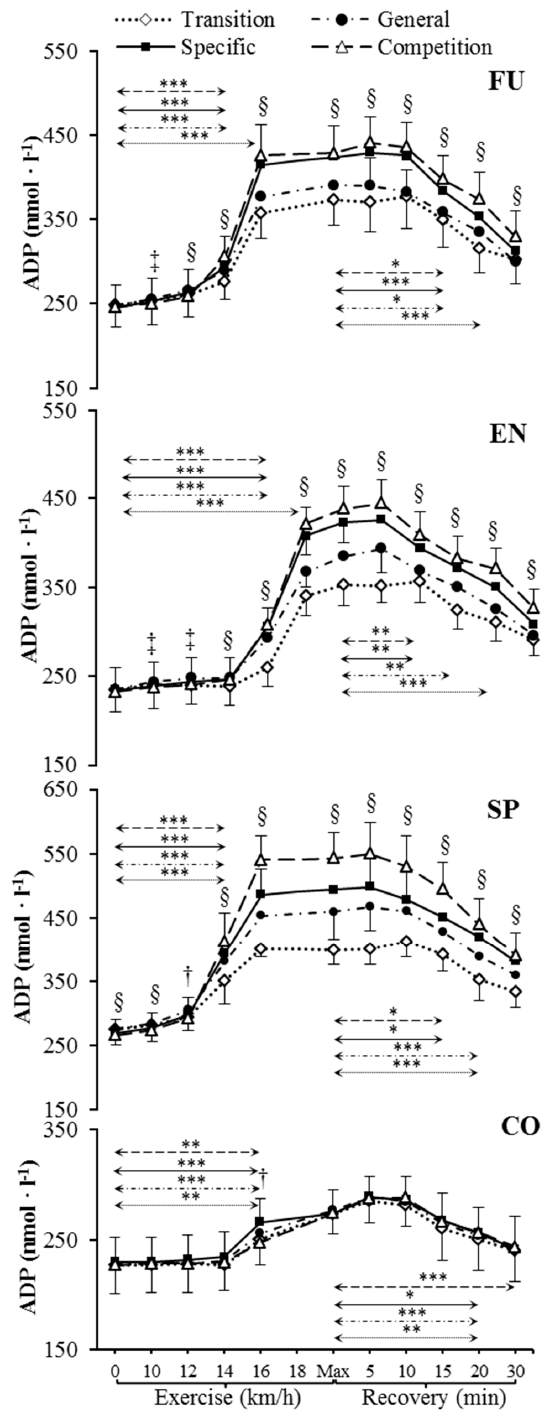
Figure 2. Venous plasma [ADP] before exercise, during incremental treadmill test until exhaustion, and post-exercise recovery in futsal players (FU; n = 11), endurance athletes (EN; n = 11), sprinters (SP; n = 11), and control group (CO; n = 11) in four consecutive training phases. Arrows indicate the first significant di ff erences from samples taken at rest and maximal exercise within examinations. Significant di ff erences between blood sampling points: *** p < 0.001, ** p < 0.01, * p < 0.05. Significant di ff erences between examinations at the same sampling point: § p < 0.001, ‡ p < 0.01, † p < 0.05. Data are presented as means ±